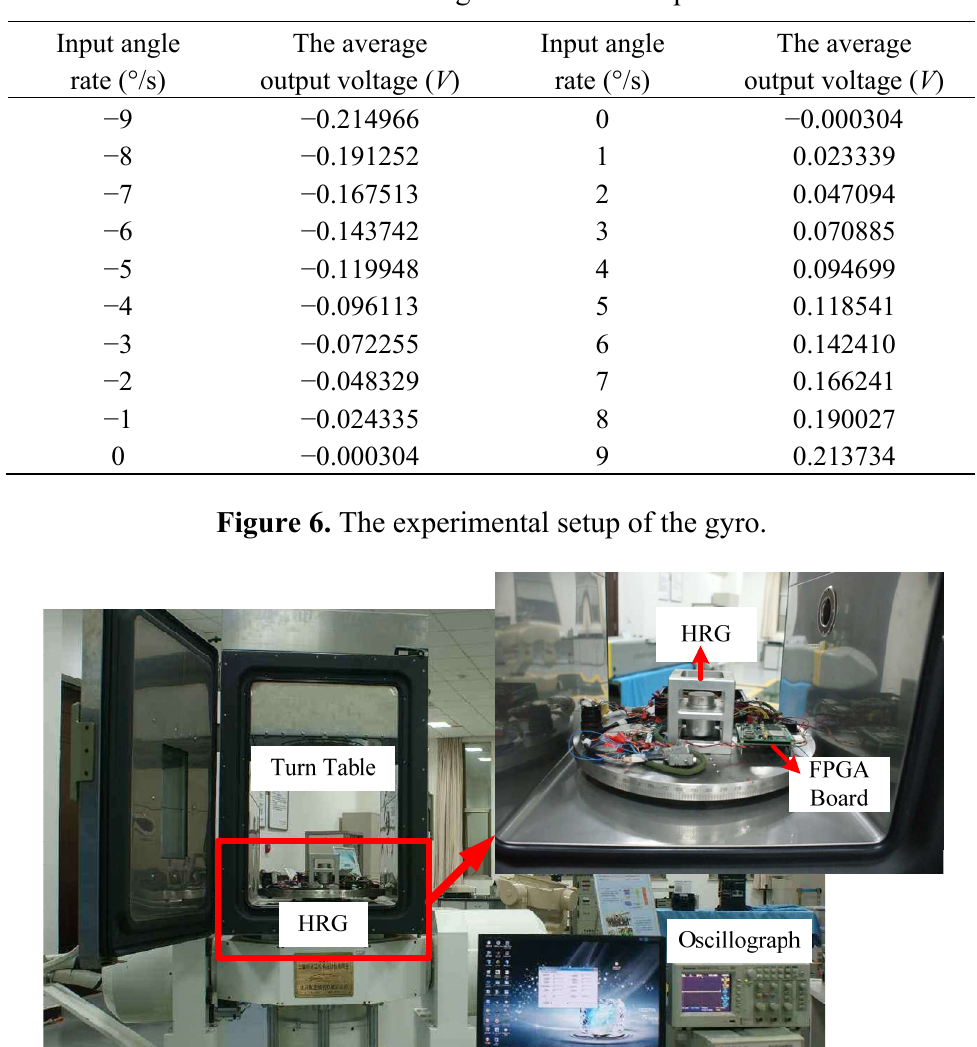
Table 1. The averaged value of each period.